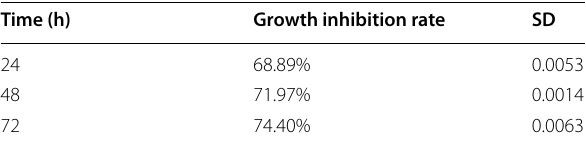
Table 6 Inhibition of NDUFV2 gene silencing on the proliferation of SMMC-7721/ADR cells: the growth inhibition rate of the positive control group x ± s , n = 3